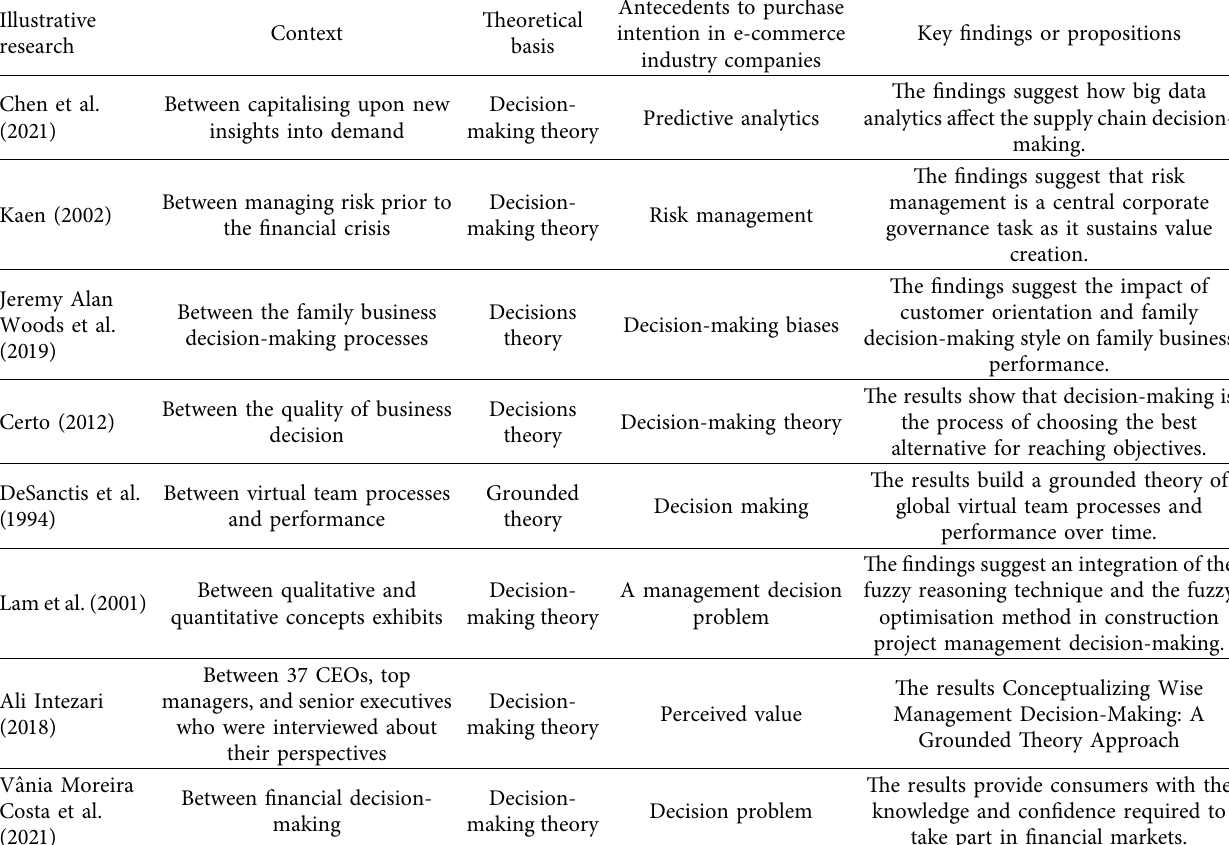
Table 1: Illustrative research summarizing the antecedents to enterprise performance in e-commerce industry